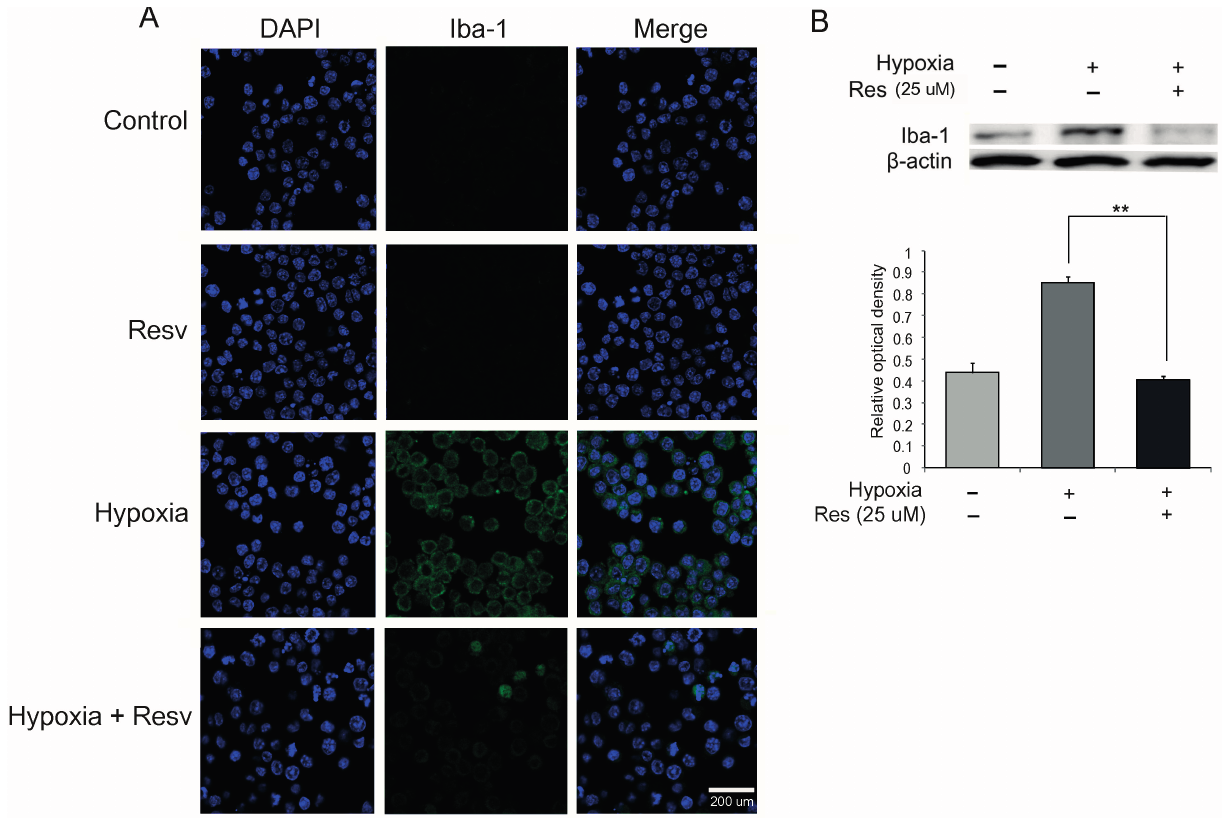
Figure 2. The expression of Iba-1 in hypoxia-injured BV2 microglia. ( A ) The level of Iba-1 (a marker of activated microglia) was evaluated by immunocytochemistry. This image shows that the expression of Iba-1 in the hypoxia group exposed to hypoxia was increased compared to the control group (no hypoxia). The resveratrol (25 μ M) pre-treatment group (Hypoxia + Resv) showed a decrease of Iba-1 expression compared with the hypoxia group. Resveratrol (25 μ M) decreased the activation of microglia under hypoxic conditions; ( B ) Western blotting data showed that the protein level of Iba-1 was increased in the hypoxia group compared to the control group. Resveratrol (25 μ M) decreased the protein level of Iba-1 in BV2 microglia under hypoxic conditions. β -actin was used as an internal, loading control (mean ± S.E.M., n = 3). ** p < 0.01 (compared to the hypoxia group). Control : normal control group, Hypoxia : hypoxia injury group for 4 h, Resv : resveratrol (25 μ M) treatment group under normal condition, Hypoxia + Resv : resveratrol (25 μ M) pre-treatment before 4 h hypoxia injury, Res ( 25 μ M ): 25 μ M resveratrol pre-treatment for 3 h. 4',6-diamidino-2-phenylindole (DAPI): blue, Ionized calcium binding adaptor molecule 1 (Iba-1): green, Scale bar: 200